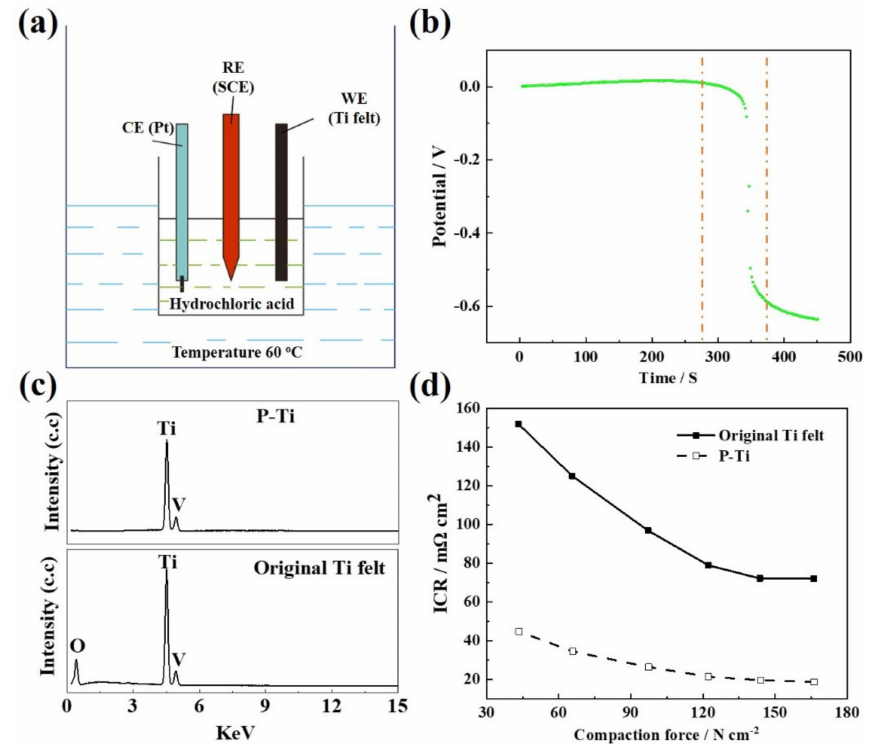
Figure 2. Schematic illustration of the three-electrode system for ( a ) in situ OCP recording, ( b ) the OCP change with time during the pickling process of Ti felt, ( c ) EDS spectrum, and ( d ) the relationship between ICR and compaction force of the original Ti felt and the